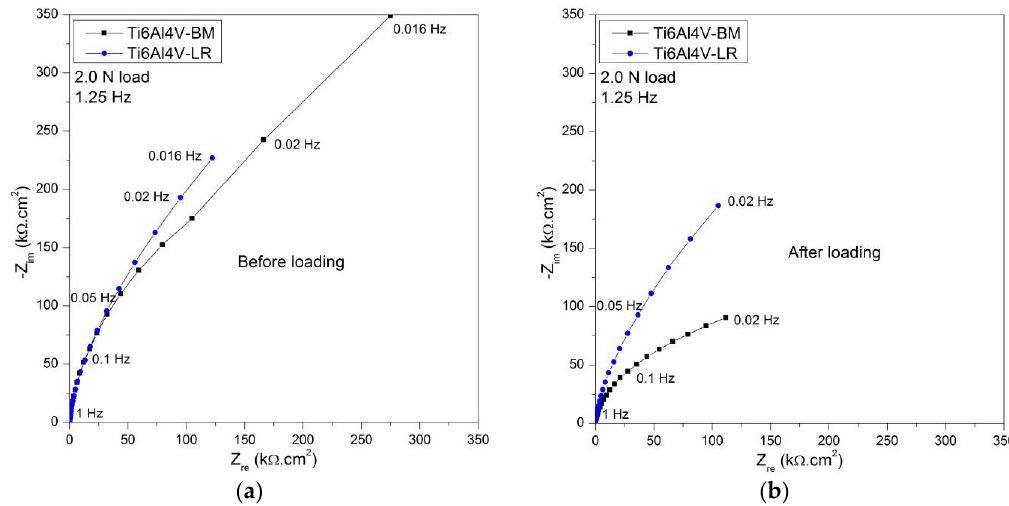
Figure 12. Optical images of wear tracks: ( a ) Ti 6 Al 4 V-BM; ( b ) Ti 6 Al 4 V-LR.